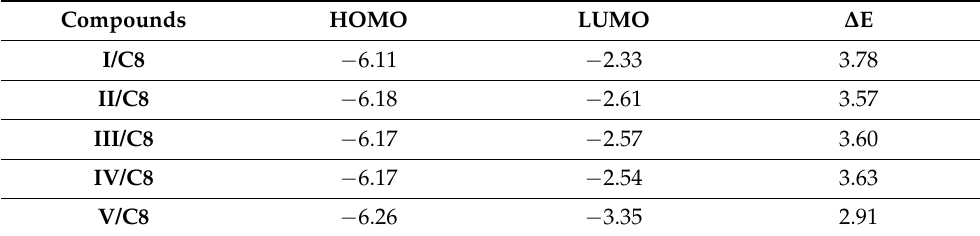
Table 2. FMO Energies (eV) and their values for the prepared para-octyloxy benzoic acid supramolec- ular complexes ( I-V ) C8 .